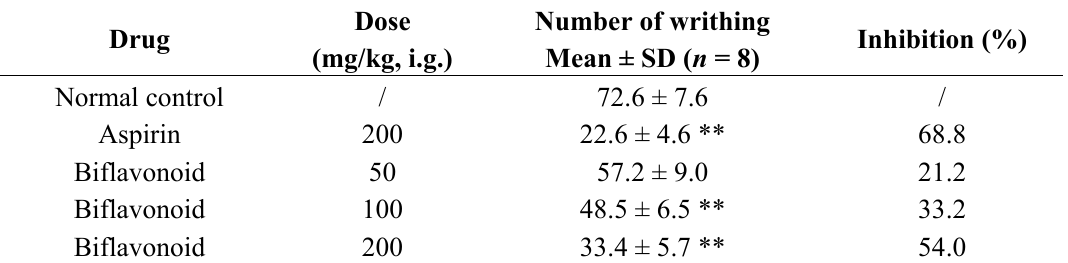
Table 4. Inhibition on acetic acid induced writhing in mice by the biflavonoid.